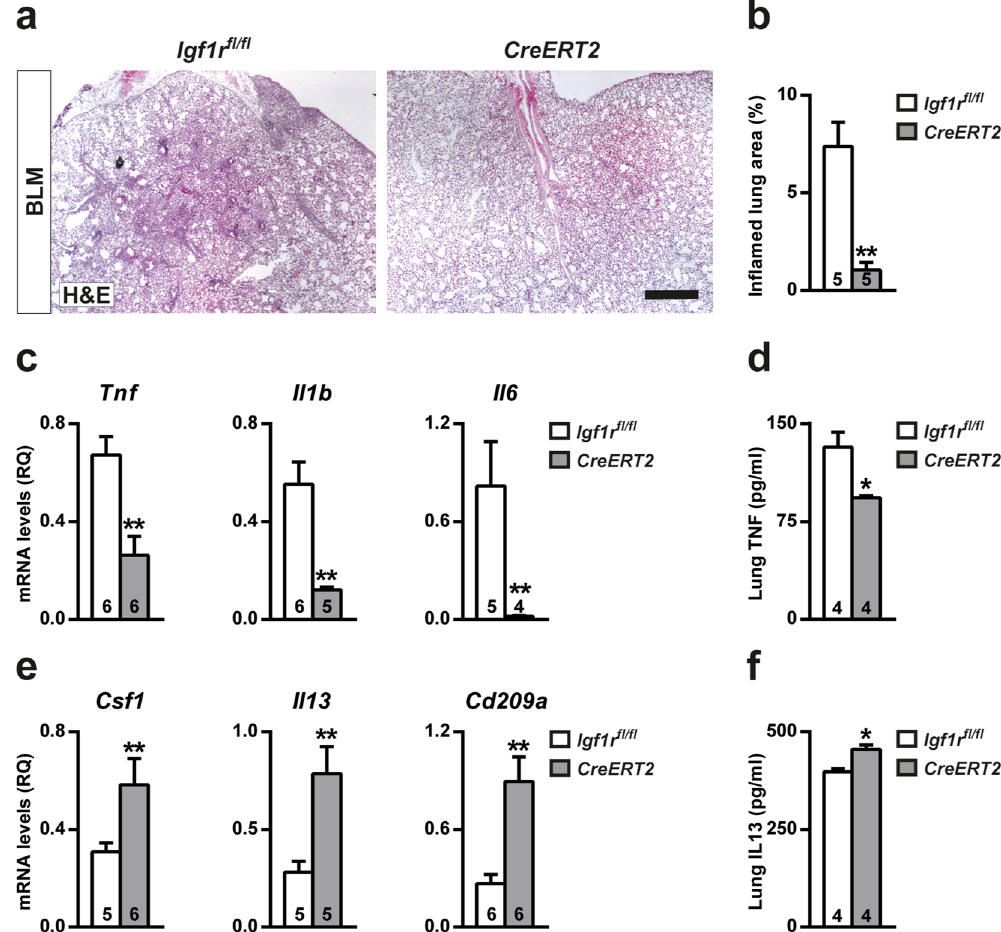
Figure 4. Decreased inflammation and increased resolution marker levels in IGF1R-deficient lungs following BLM treatment. ( a ) Representative images of H&E stained inflamed lung sections (scale bar: 0.5 mm), ( b ) quantification of inflamed lung area to total lung surface, ( c , e ) lung tissue mRNA expression of pro- inflammatory ( Tnf , Il1b and Il6) and injury resolution phase ( Il13 , Csf1 and Cd209a ) markers, and ( d , f ) TNF and IL13 levels in lung homogenate from BLM-treated UBC-CreERT2 ; Igf1r fl / fl ( CreERT2 ) mice at D3. Numbers within graphic bars indicate the number of mice analyzed and data are expressed as mean ± SEM. * p < 0.05; ** p < 0.01 (Mann-Whitney U test). BLM,